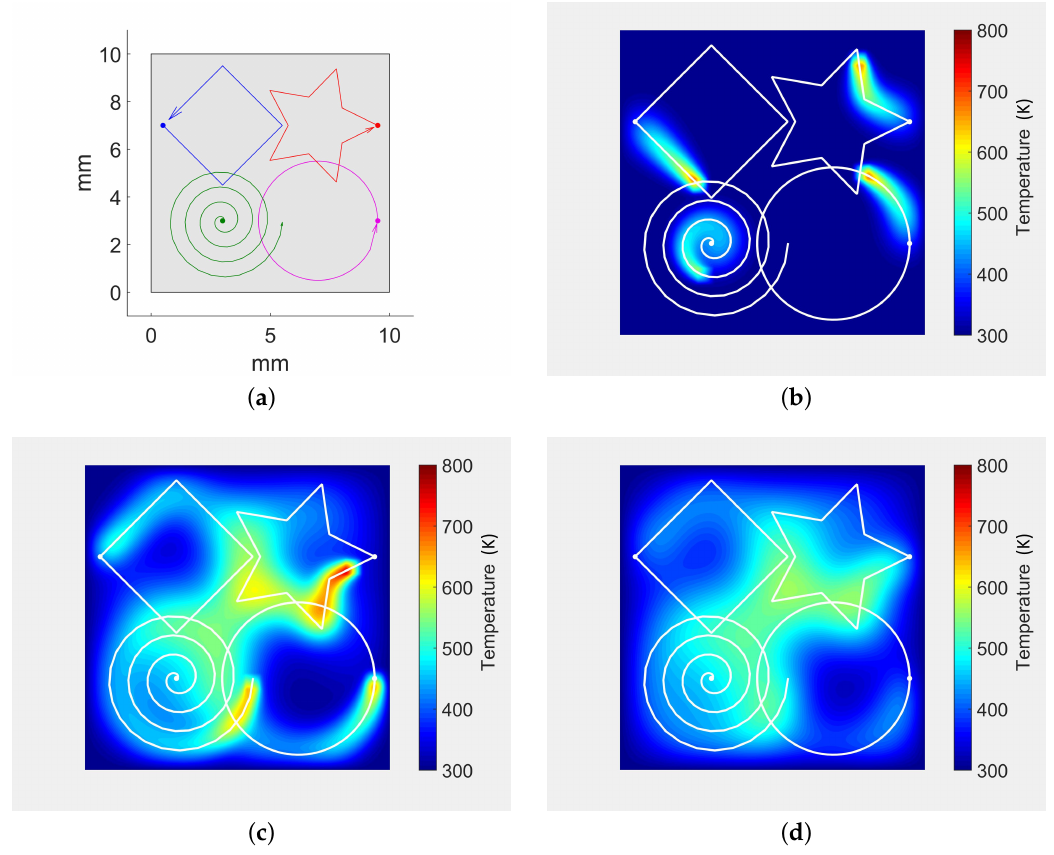
Figure 6. Laser trajectories and temperature history for time and space overlapping trajectories. ( a ) planned laser trajectories: Square, Star, Spiral, Circle; ( b ) t = 0.03 s. All trajectories start at t = 0 s; ( c ) t = 0.158 s. Square and Circle trajectories finished; ( d ) t = 0.2 s. All trajectories finished. The sheet cools